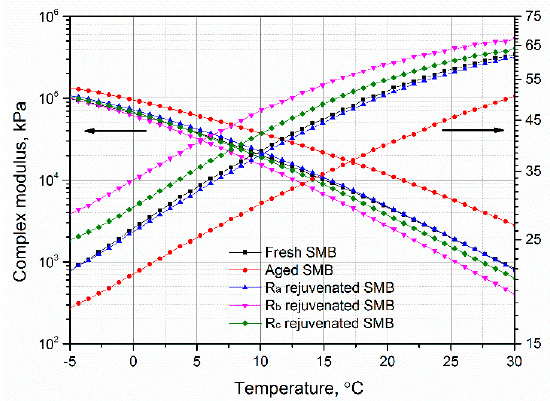
Figure 7. Effect of rejuvenating systems on the complex modulus and phase angle of aged SMB.